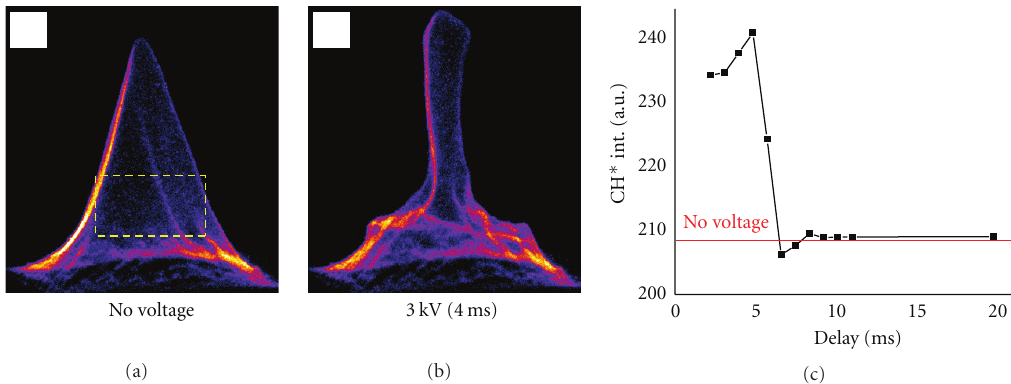
Figure 7: CH chemiluminescence images showing a comparison of flame structure for a Φ = 1.1, v = 1 . 58m/s flame with no voltage (left), +2.7kV applied voltage, and the resultant CH chemiluminescence intensity plot (right). Note the local reduction in flame height and a 16% increase in CH chemiluminescence intensity due to disturbance in the middle of the flame. Image is rescaled to highlight the high intensity regions. Region of interest used for CH intensity plot is shown on the left.